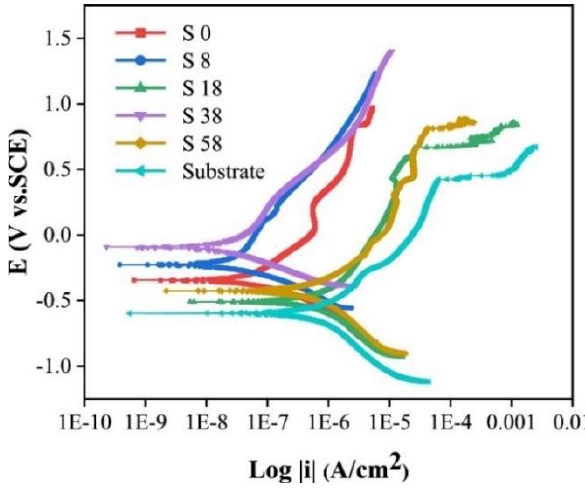
Figure 9. Potentiodynamic polarization curves of the (CrNbTiAlV)N x films at different nitrogen flow rates (in sccm) and substrate in artificial seawater at room temperature, where V is the corrosion potential and i is corrosion current density. Reproduced with permission from [43]. Copyright 2022, Elsevier.